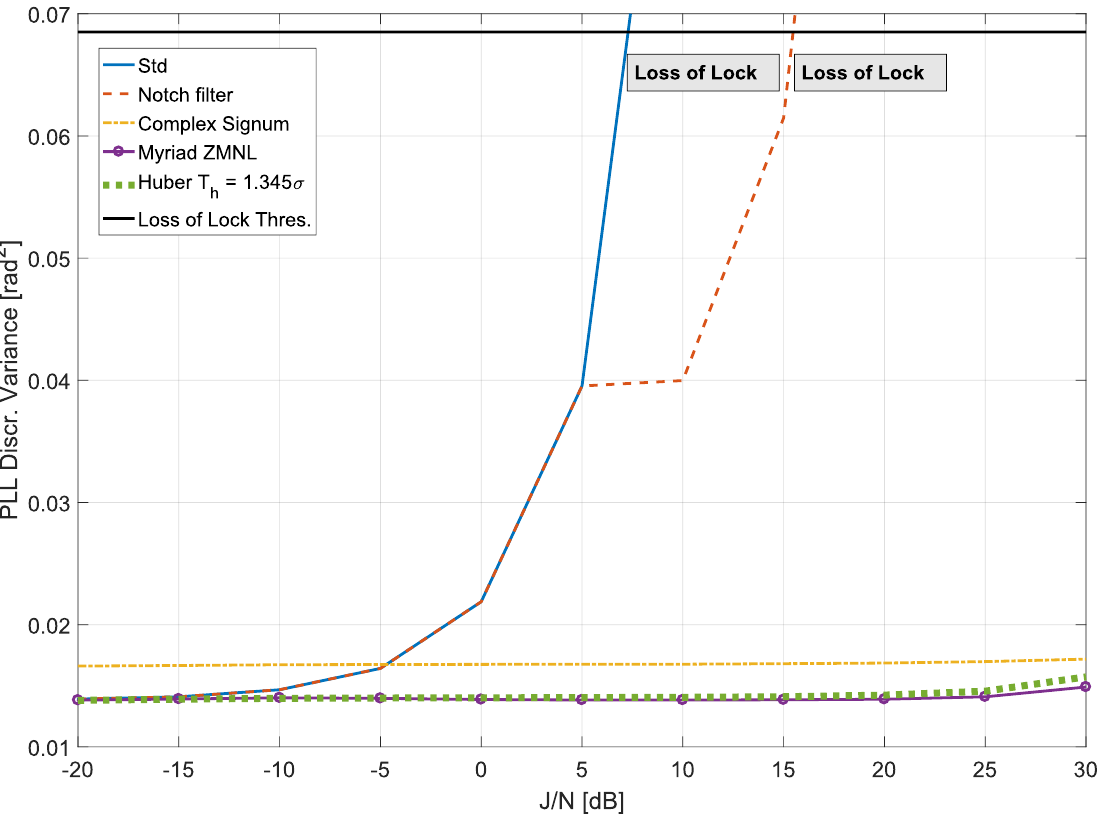
Figure 5. Variance of the PLL discriminator versus the J / N of a swept interference. Comparison of standard (no anti-jamming) processing, adaptive notch filtering, complex signum ZMNL, myriad ZMNL and Huber’s